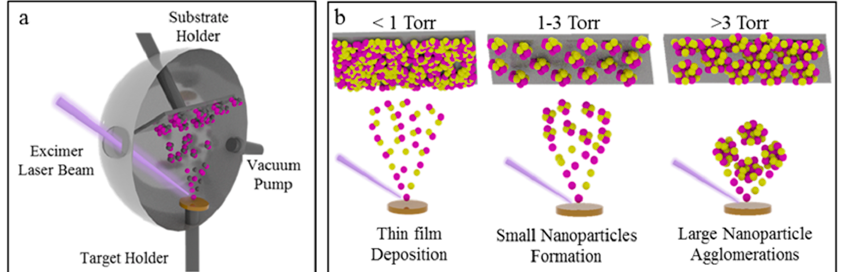
Figure 1. Schematic illustration of the experimental setup used for the formation and assembly of the 2D nanoparticles in this study ( a ). Schematic illustration of the laser-generated plume dynamic and evolution of nanoparticle formation as a function of background pressure ( b ).